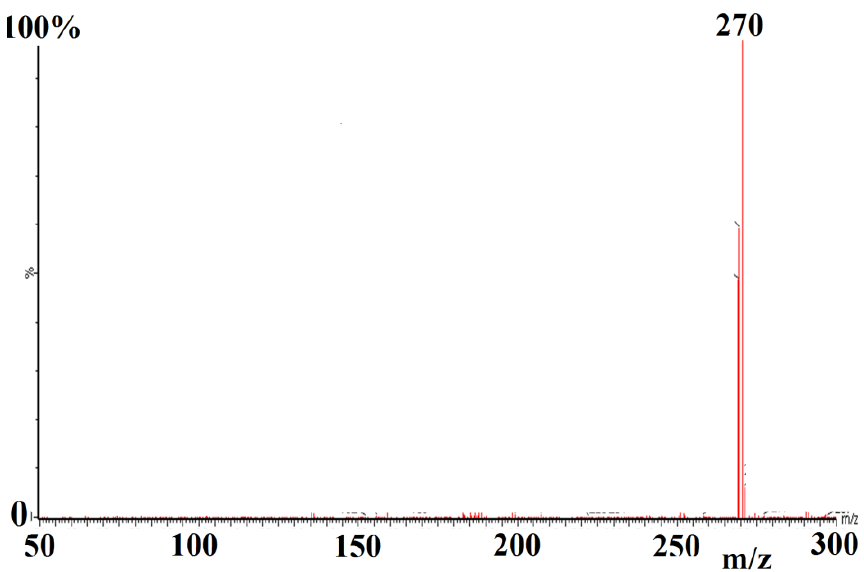
Figure 2. EI-MS spectrum of 5,5-dimethyl-2,2-di(pyridin-2-yl)hexahydropyrimidine.